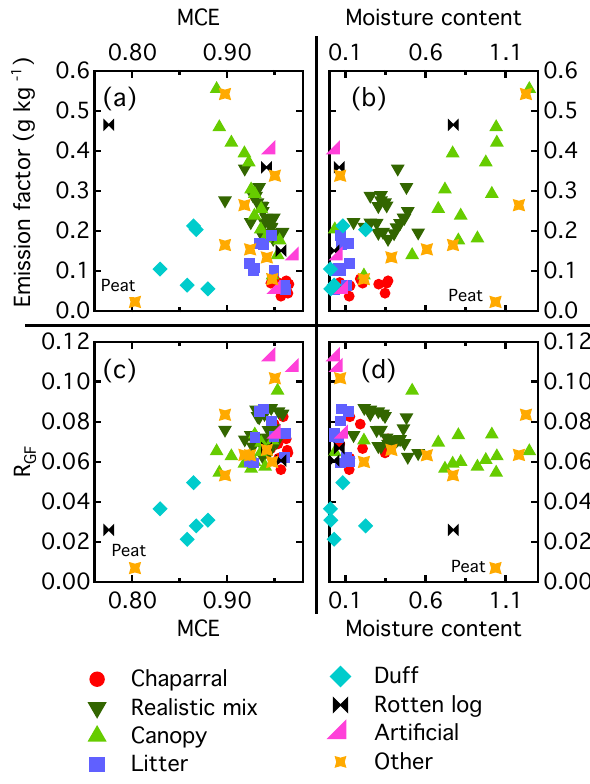
Figure 4. Glyoxal emission factors (a, b) and R GF values (c, d) for each fire as a function of either MCE (a, c) or fuel moisture content (b, d)